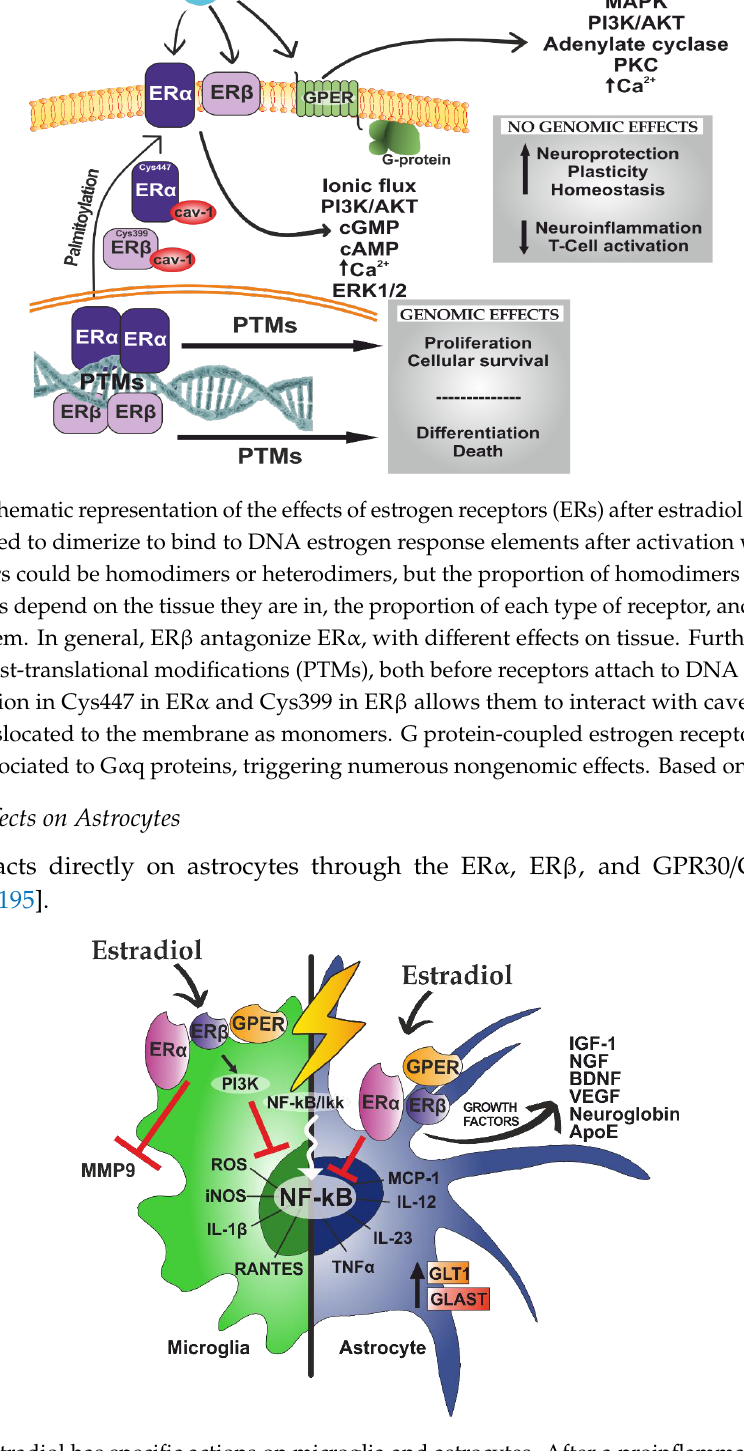
Figure 3. Estradiol has specific actions on microglia and astrocytes. After a proinflammatory stimulus, nuclear factor kappa-light-chain-enhancer of activated B cells (NF- κ B) is translocated to the nucleus to activate genes of di ff erent proinflammatory pathways. This spreads the damage in the brain by increasing proinflammatory mediators. In microglia, estradiol inhibits the release of metalloproteinase 9 (MMP9). In addition, by activating PI3K, NF- κ B translocation to the nucleus is inhibited. In astrocytes, estradiol increases the production of growth factors and glutamate transporters (GLT1 and GLAST) and blocks NF-kB translocation. Based on